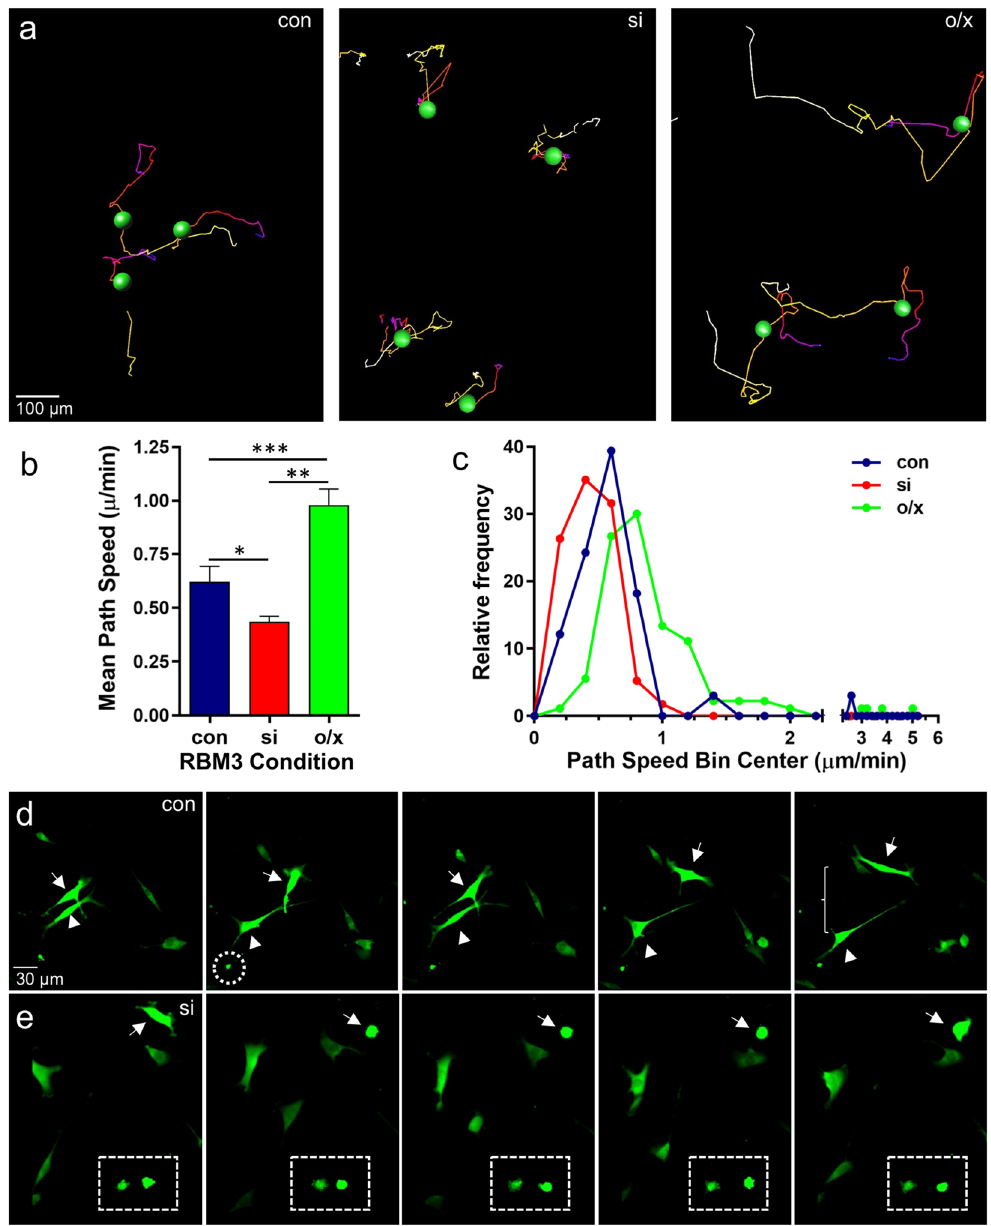
Figure 3. RBM3 promotes migration and regulates migration mode. B104 cells were transfected with EGFP alone (con), EGFP plus RBM3 siRNA to knockdown RBM3 (si), or a construct encoding an EYFP-RBM3 fusion protein (o/x). After 48 hrs, cells were replated onto fibronectin-coated coverslips and transferred to a homeostatic chamber for live imaging of cell movement. (a) Representative images of cell migration paths during live imaging of EGFP and EYFP-labeled B104 cells in the three treatment conditions. Path color indicates temporal progression: start = white; end = red. ( b ) Graph of the average path speeds displayed by B104 cells in the three treatment conditions (n = 33, con; n = 57, si; n = 90, o/x; * p < 0.05, ** p < 0.0001; *** p < 0.001 2-tailed t-tests). ( c ) Relative frequency distribution of path speeds in the three treatment conditions; knockdown and overexpression of RBM3 significantly skewed the distribution of path speeds (con vs si, p < 0.05; con vs o/x, p < 0.0005; si vs o/x, p < 0.0005, Kolmogorov-Smirnov test). ( d ) Frames from Supplementary Movie S2 showing filopodia-based, mesenchymal–like migration of highly polarized cells in the control condition (con). Long extensions with growth cone-like ends (hatched circle) are evident in the control (and RBM3 overexpression) condition, but not after RBM3 knockdown (si). Two highly polarized cells (arrowhead and arrow) are seen migrating away from each other ( e ) Frames from Supplementary Movie S5 illustrating the morphology of cells in the knockdown condition as they migrate; some remain rounded (hatched rectangle) with continued blebbing. Another cell can be seen switching from a slightly elongated state with short protrusions, to a rounded, blebbing state